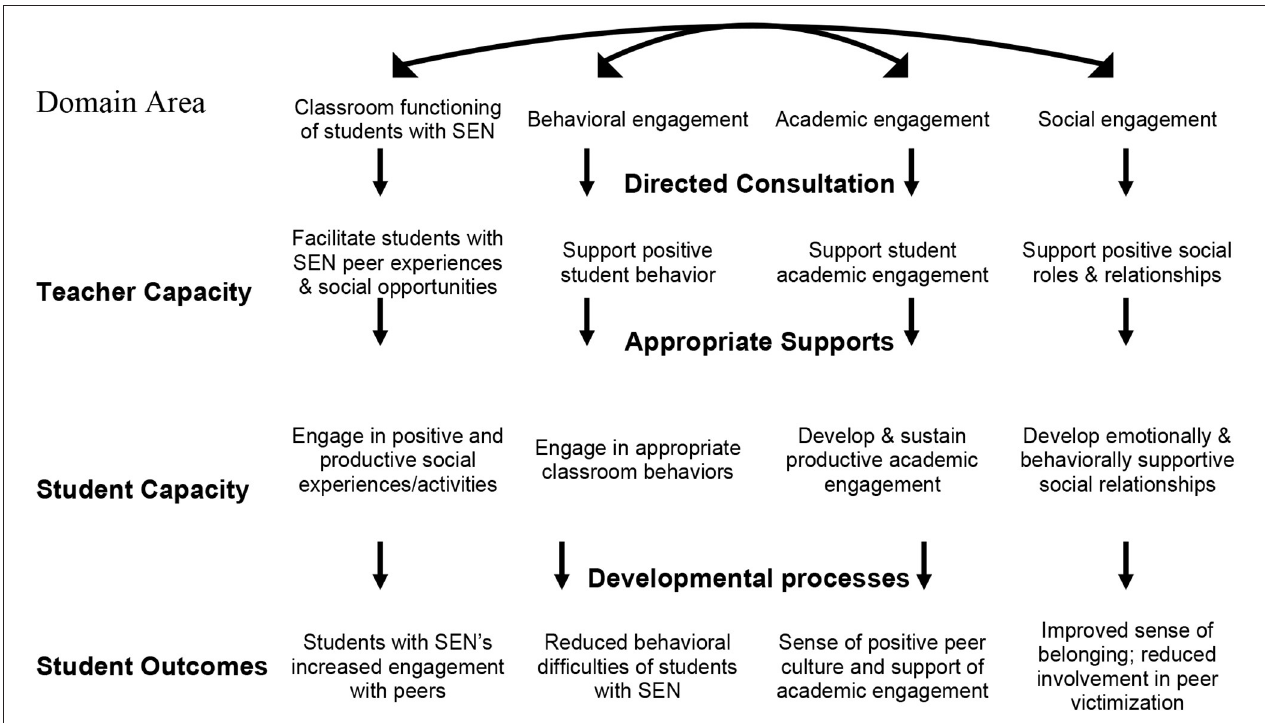
FIGURE 2 | BASE model theory of change to support the social inclusion of students with